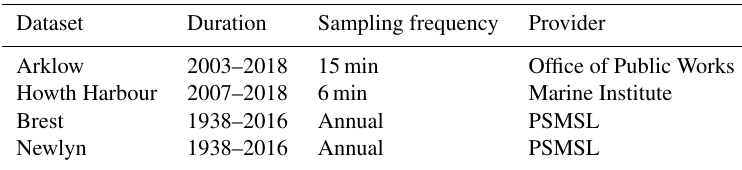
Figure 1. Monthly MHW in Dublin from the Port Authority, Greene, harbourmaster and NTGN datasets. A high level of agreement is found between the records, indicating consistent datum definition, with only a small adjustment of 0.008m to the Greene dataset required for complete reconciliation. Table 2. Details of the four datasets used for comparison with Dublin